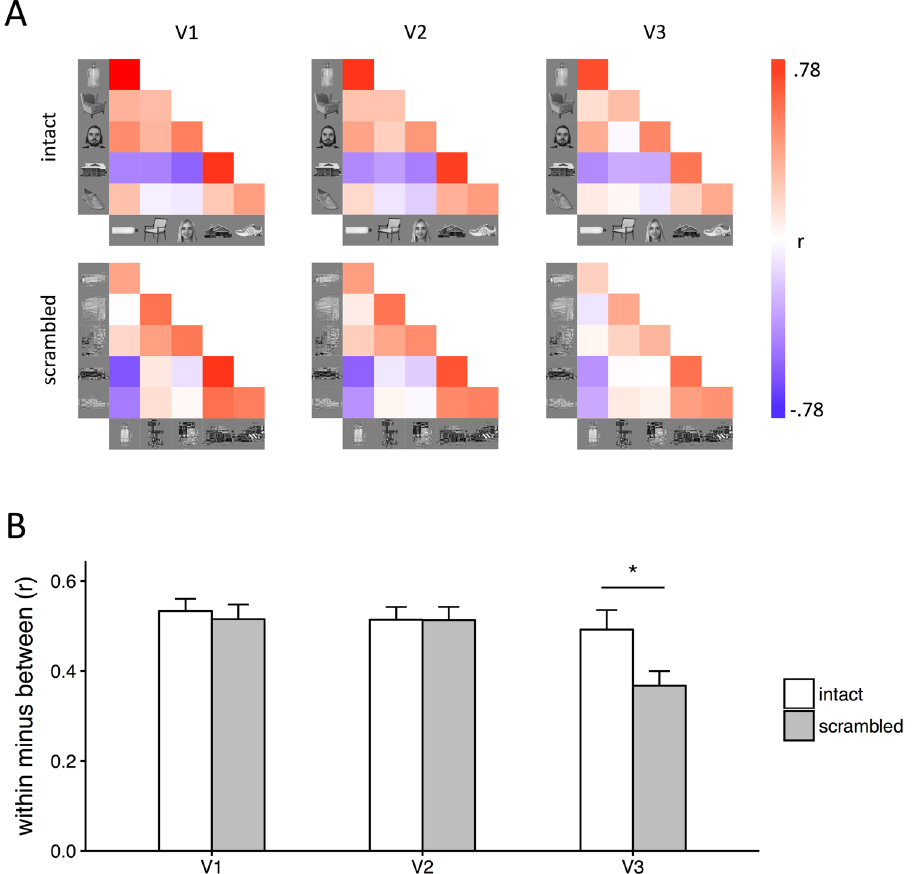
Figure 4. ( A ) Similarity matrices showing the correlation in patterns of neural response to all within-category and between-category comparisons. Within-category comparisons (e.g. bottle-bottle) are shown on the diagonal. ( B ) Bar graph showing the mean within-category and between-category correlations for intact and scrambled images across participants. There was a significant interaction between Comparison, Image Type and Region, which was due to more distinct (within > between) patterns of neural response to intact relative to scrambled images in V3. Error bars show ± 1 SEM. * p < 0.05, FDR